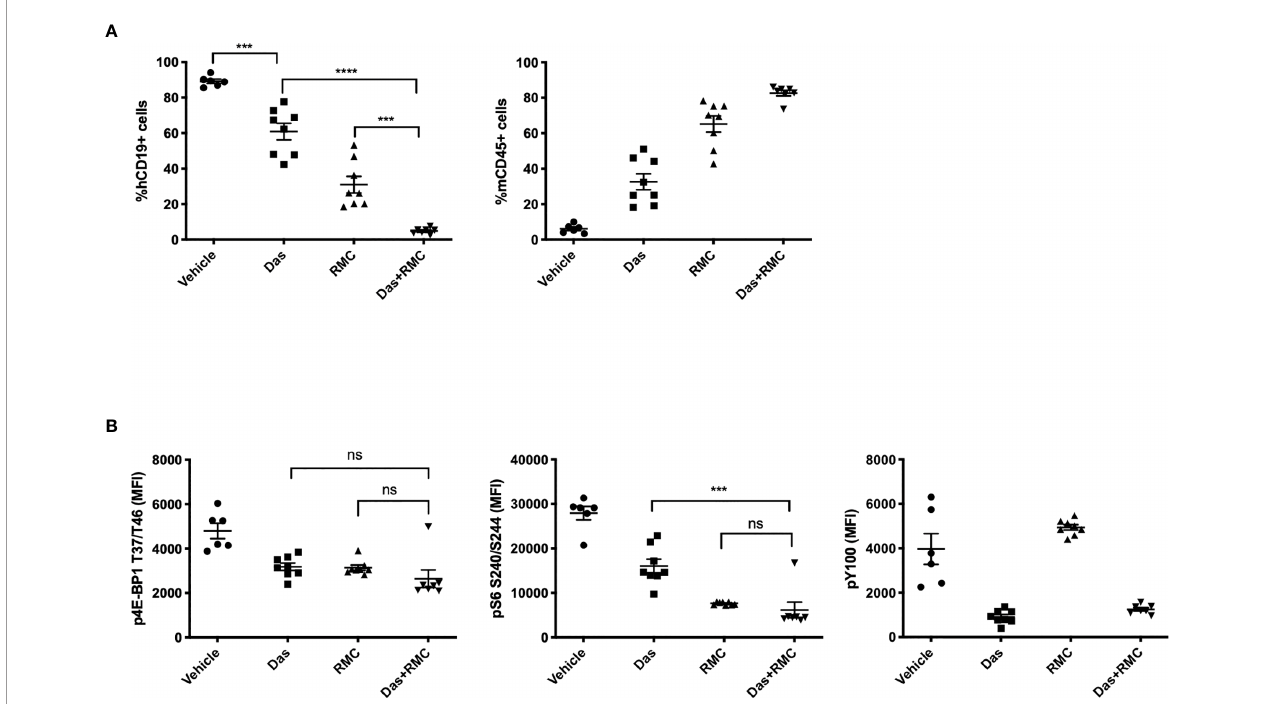
FIGURE 5 | RMC-4627 enhances the anti-leukemic activity of dasatinib in a Ph+ B-ALL xenograft model. (A) Percentage of human leukemia (% hCD19+ cells) (left) and percentage of mouse lymphocytes (% mCD45+ cells) in bone marrow of SUP-B15 xenografts dosed with Vehicle, Das (dasatinib, 5 mg/kg, po qd), RMC (RMC-4627, 3 mg/kg, ip qw), and Das + RMC (dasatinib, 5 mg/kg, po qd; RMC-4627, 3 mg/kg, ip qw). In total, animals received 4 doses of RMC-4627 and 22 doses of dasatinib. Data are the mean percentages of each group (n = 8; center line) with error bars representing SEM. Statistical test: ordinary one-way analysis of variance (ANOVA) with post-hoc Tukey ’ s multiple comparison test (*** P = 0.0001 for Vehicle and Das; **** P < 0.0001 for Das and Das+RMC; *** P = 0.0002 for RMC and Das+RMC). (B) Levels of p4E-BP1 T37/T46, pS6 S240/S244, and phosphotyrosine (pY100) determined in bone marrow of SUP-B15 xenografts (hCD19+ population) 4-5 hours after the fi nal dose of the repeat dosing schedule (described above). Data are the mean signal of each group (n = 8; center line) with error bars representing SEM. Statistical test: ordinary one-way analysis of variance (ANOVA) with post-hoc Tukey ’ s multiple comparison test for p4E-BP1 (ns P = 0.46 for Das and Das+RMC; ns P = 0.53 for RMC and Das+RMC) and p-S6 (*** P = 0.0001 for Das and Das+RMC; ns P = 0.86 for RMC and